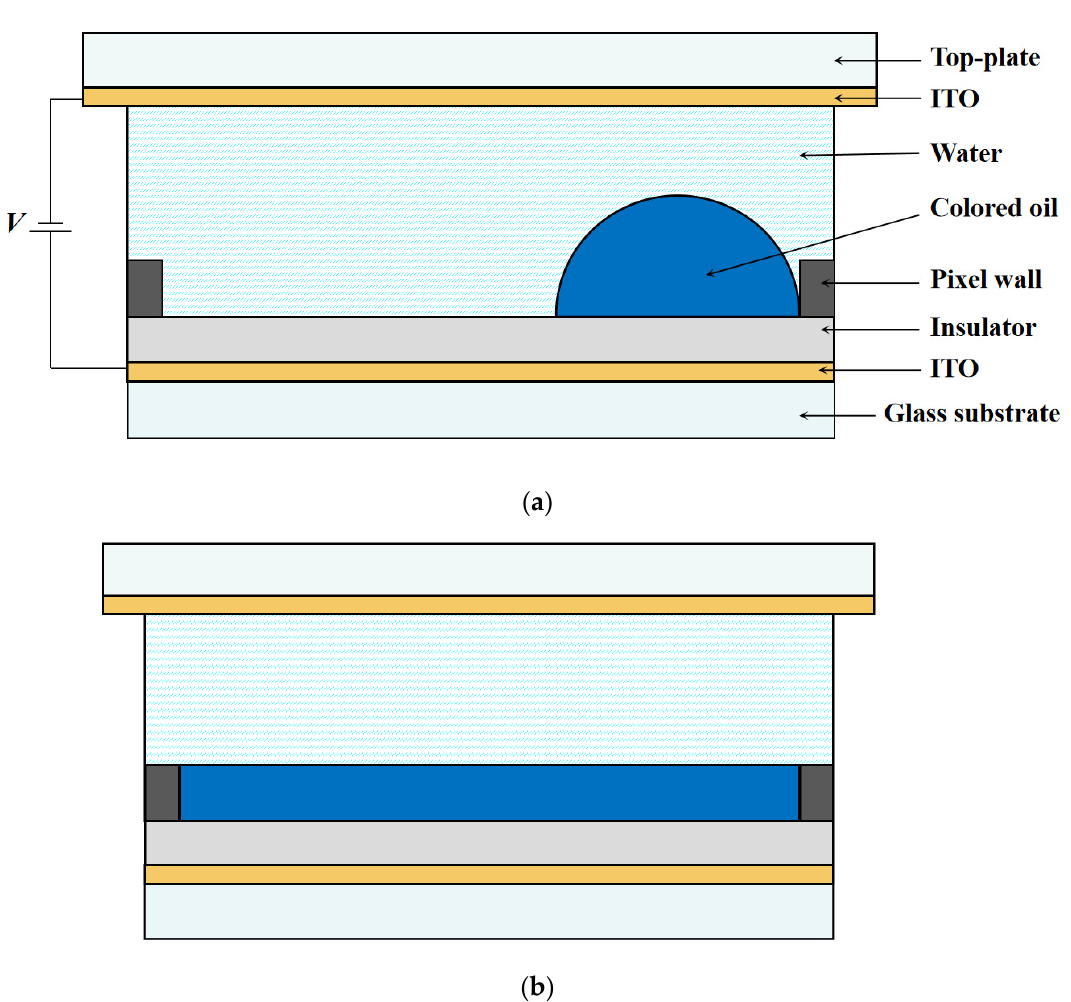
Figure 1. Pixel structure and operating principles of EWDs. The optical stack consists of a top plate, a glass substrate, indium tin oxide (ITO) electrodes, a hydrophobic insulator layer, pixel wall, colored oil, and water. ( a ) With an applied voltage, oil is shrunk to a corner and the pixel is in a white on-state. ( b ) With no voltage applied, oil spreads uniformly and the pixel is in a colored off-state. Electrostatic field force is a key factor affecting oil movement of EWDs [17,18]. The motion of oil is determined by electric field intensity. According to the principle of elec- trowetting, for an oil droplet, applying an electric field to only one side of the oil causes an imbalanced force on both sides of the oil, which drives the whole oil flow to one side [19–21]. Figure 2 shows a schematic diagram of oil movement by electrowetting. The bottom sub- strate contains a group of addressable electrodes. The contact angle is varied by the applied voltage, and the oil is deformed and shifted by electric field forces. The diagram shows that the contact angle θ decreases by activating electrode 2. Then, the oil deforms accordingly and moves to the right